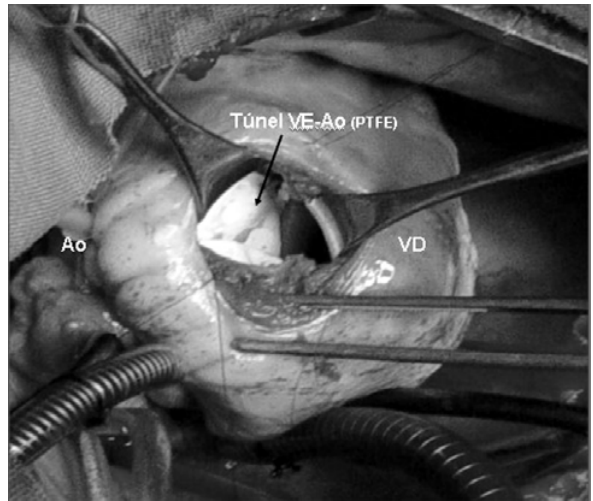
Fig. 3 - Fotografia cirúrgica. Aspecto da face anterior do ventrículo direito (VD). Abordagem dos defeitos cardíacos pela ventriculotomia direita, para a confecção de túnel entre o ventrículo esquerdo e aorta (Túnel VE-Ao), com placa de "Polytetrafluoroethylene" (PTFE)